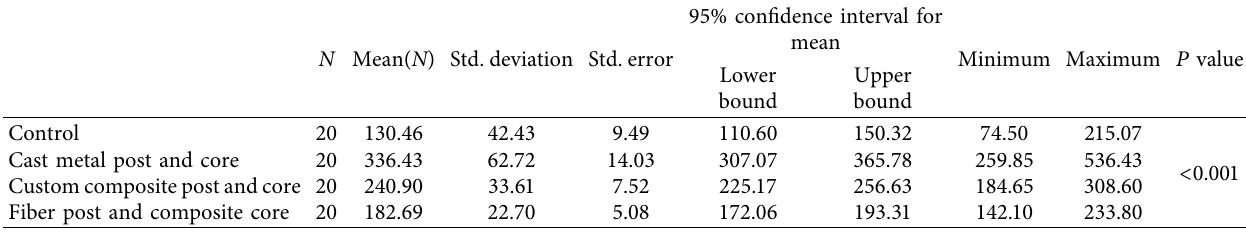
Table 2: Comparison of fracture resistance under static loading amongst four groups using one-way ANOVA.